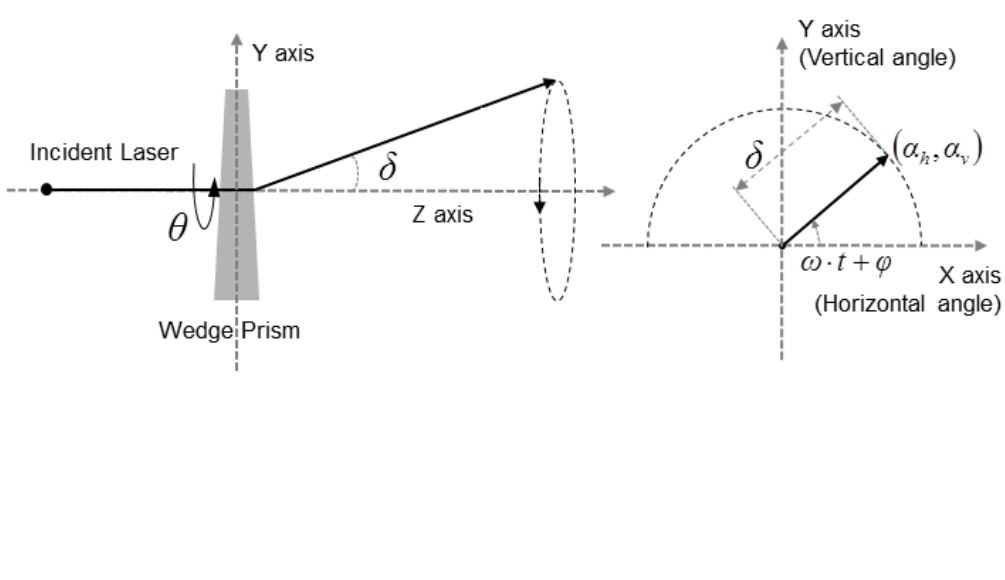
Figure 5. Geometric deflection by a wedge prism. The horizontal and vertical angular positions created by a set of four prisms for a zigzag pattern can be expressed by a trigonometric function. And 3D transformation matrices for steering the pixel ray horizontally and vertically can be